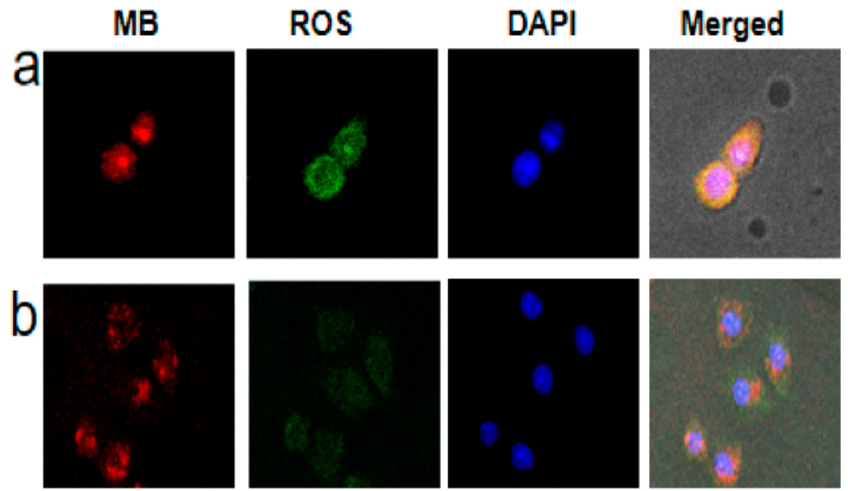
Figure 3. CLSM of HepG2 cells incubated with OCZWM ( a ) and Cu/ZIF-8@ZIF-8@WP6–MB ( b ). The scale bar is 50 μ m. ( b ) the GSH content under the OCZWM, Cu/ZIF-8@ZIF-8@WP6–MB, MB, control.